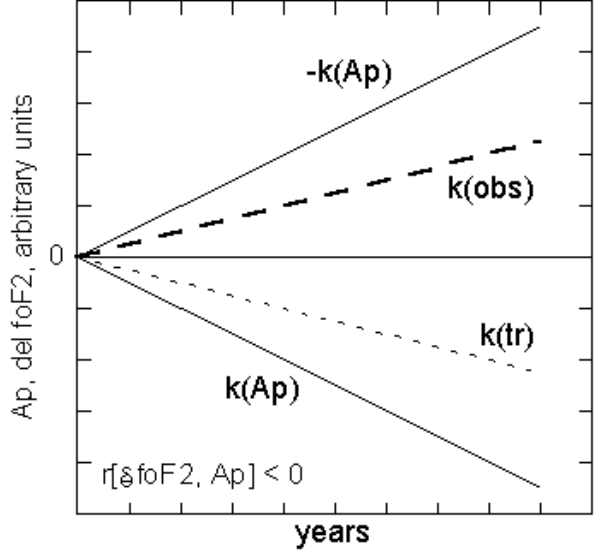
Fig. 2. The relation between the slope of various lines at the nega- tive relation between δ f o F2 and A p